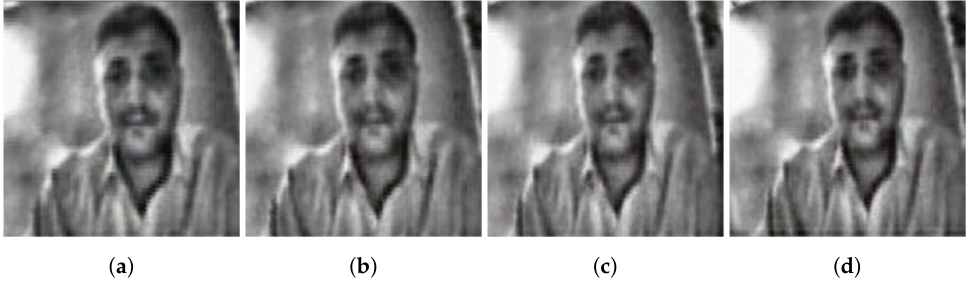
Figure 7. ( a – d ) Face frontalization using FF-GAN in six frames of the input video.